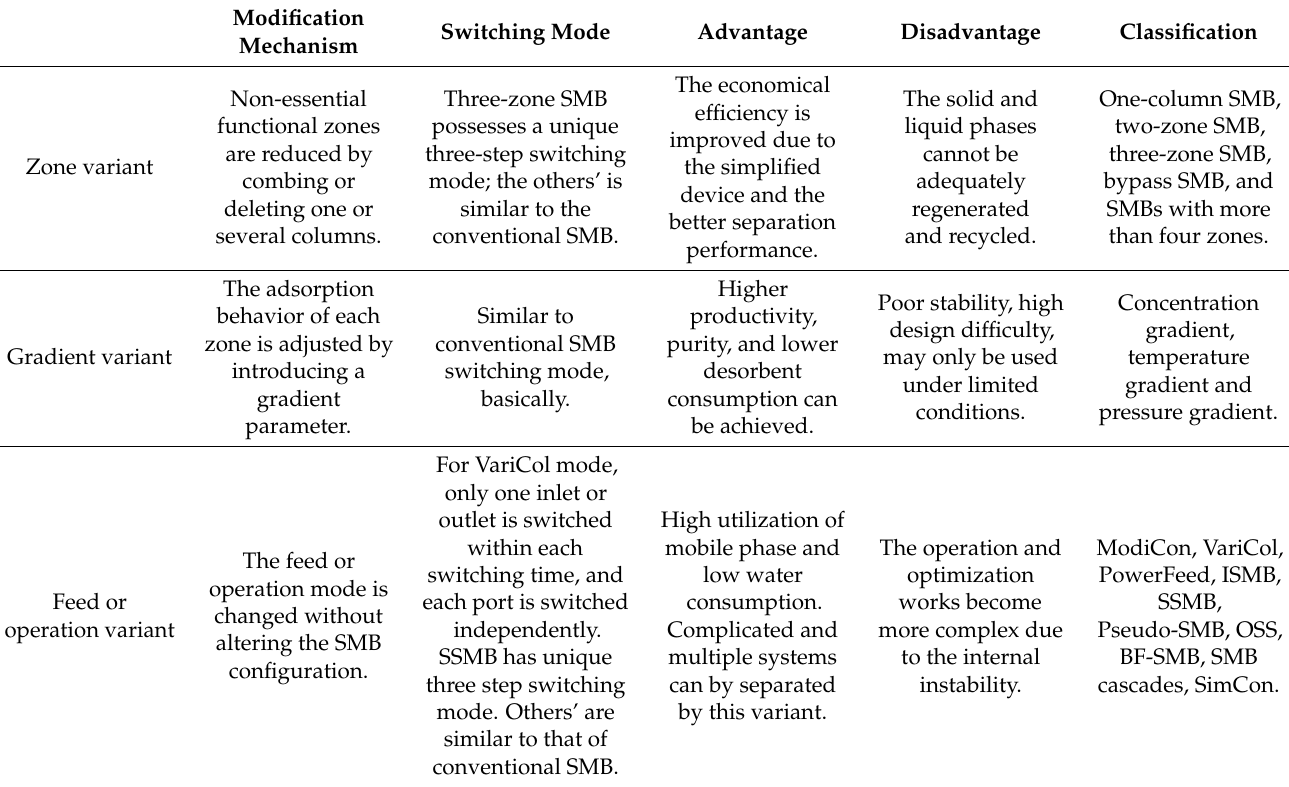
Table 1. A summary and comparison of three SMB